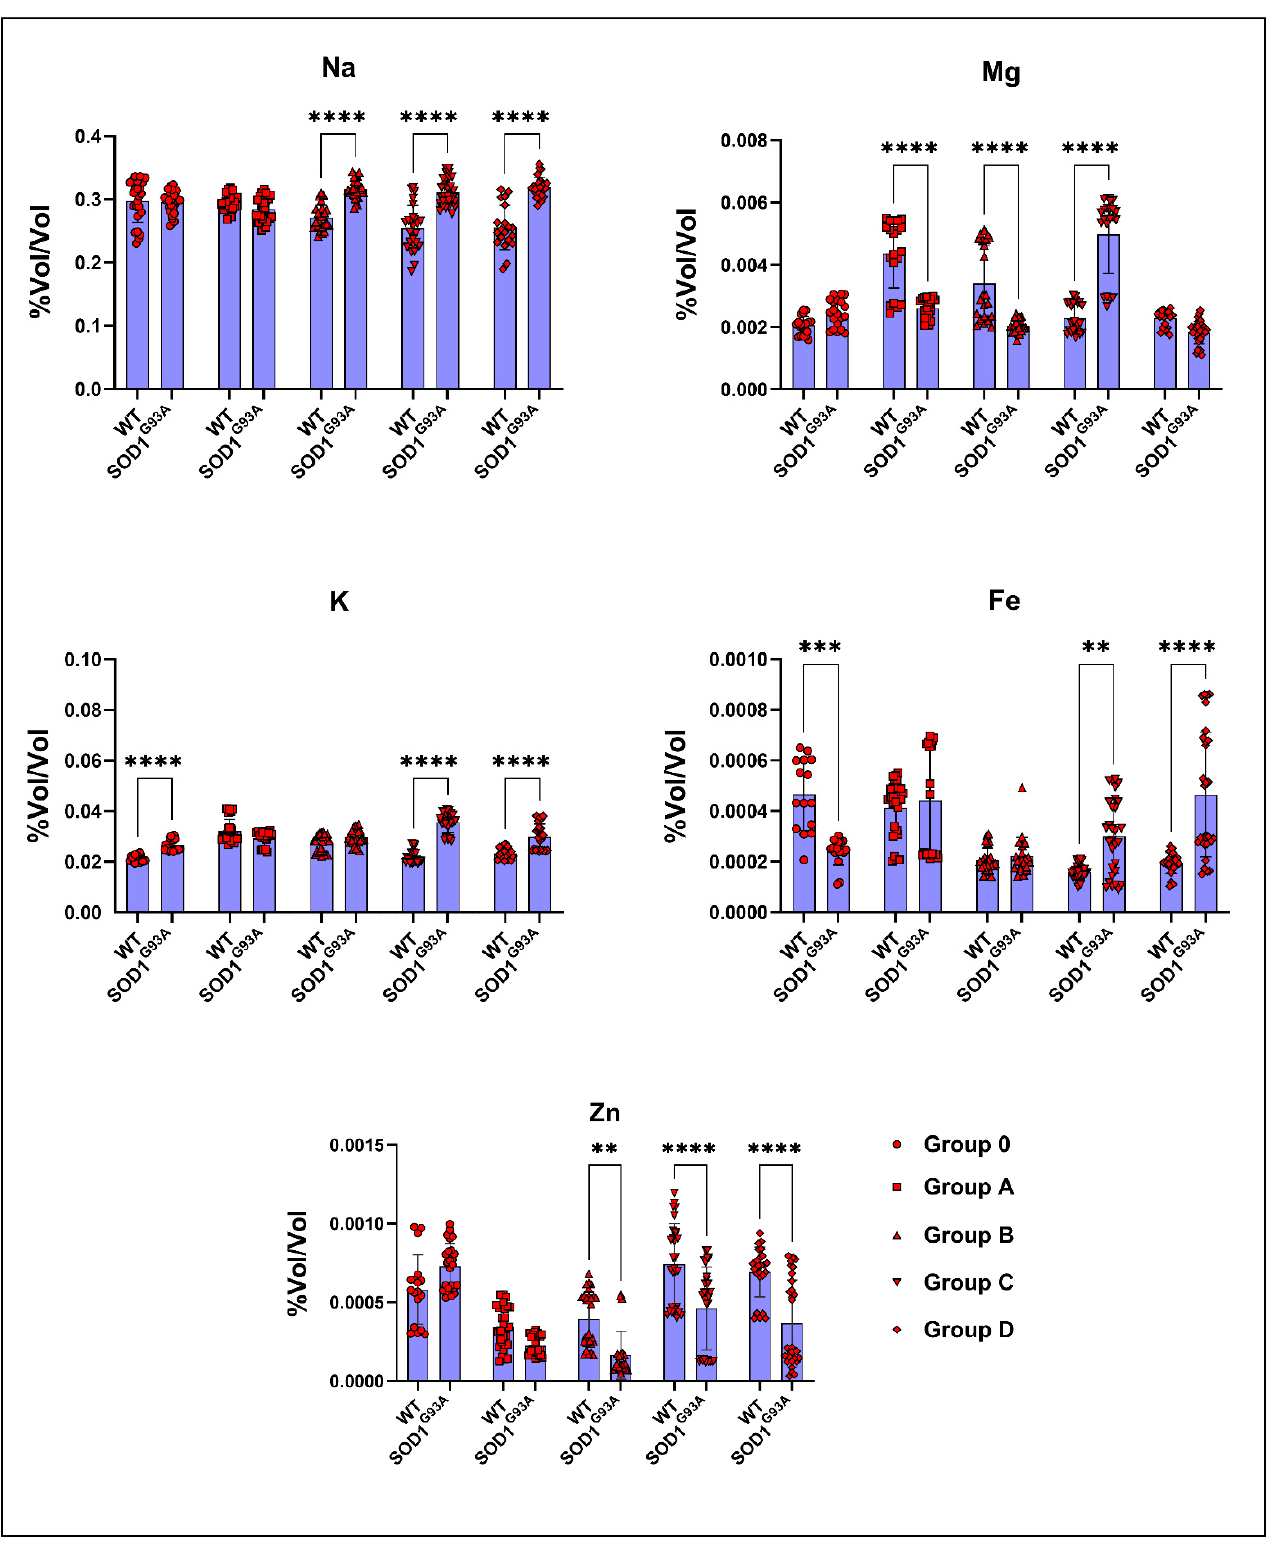
Figure 5. Serum mineral and trace element levels of the SOD1 G93A and SOD1 WT rats. All results were given as mean ± SD of n = 6–8 animals for each group. Notes: ** p ≤ 0.01, *** p ≤ 0.001, and **** p ≤ 0.0001.